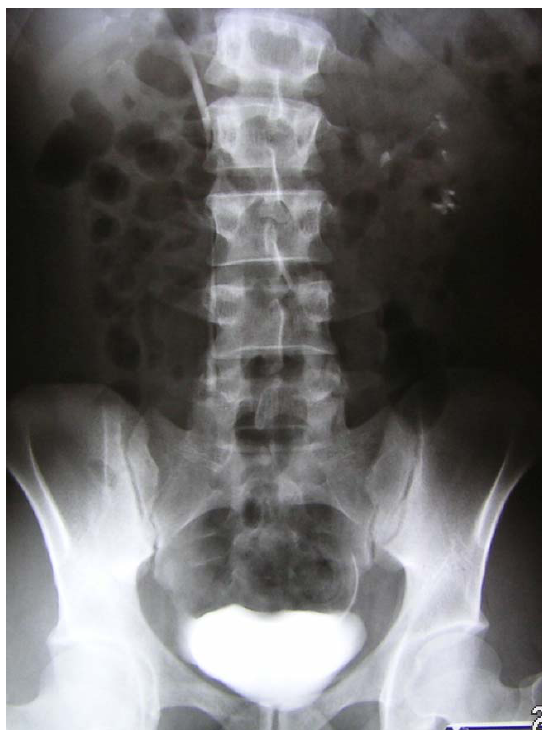
FIGURE 3. Follow up Intravenous